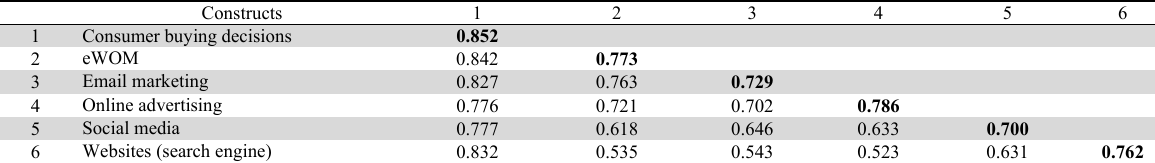
Fornell-Larcker Criterion